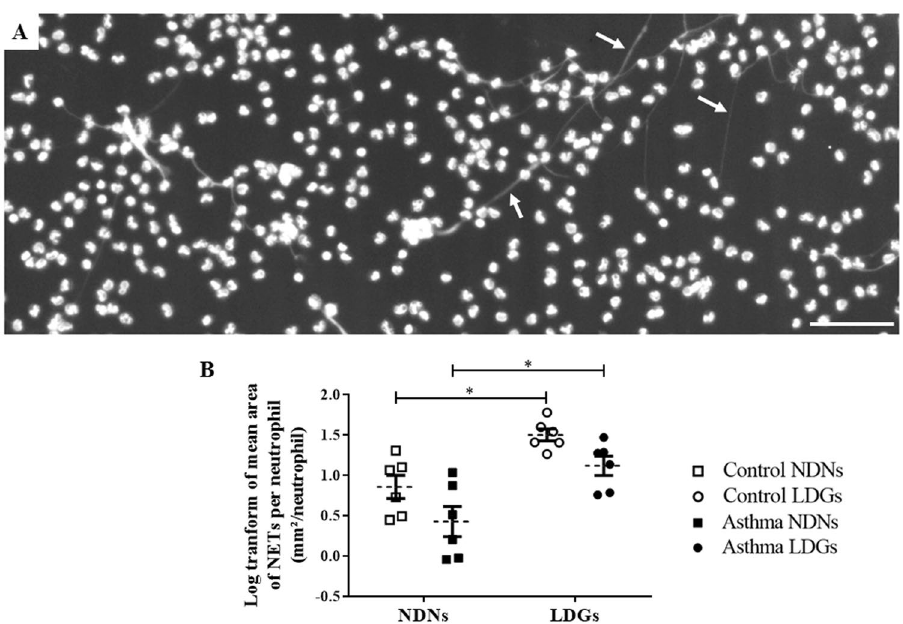
Figure 6. Neutrophil extracellular traps (NETs) production in both layers of cells. ( A ) Representative photography of using a MRC1024 confocal laser-scanning microscope at × 100 magnification (BioRad, Hercules, CA) equipped with a Nikon Eclipse TE300 camera (Nikon, Tokyo, Japan) of the low-density layer (scale bar = 100 µ m). White arrows indicate NETs’ structures. ( B ) Log transform of the mean area of NETs per neutrophil in each layer (non-stimulated NS). Each symbol denotes a single animal. Mean ± SEM for each studied population is shown. * p ≤